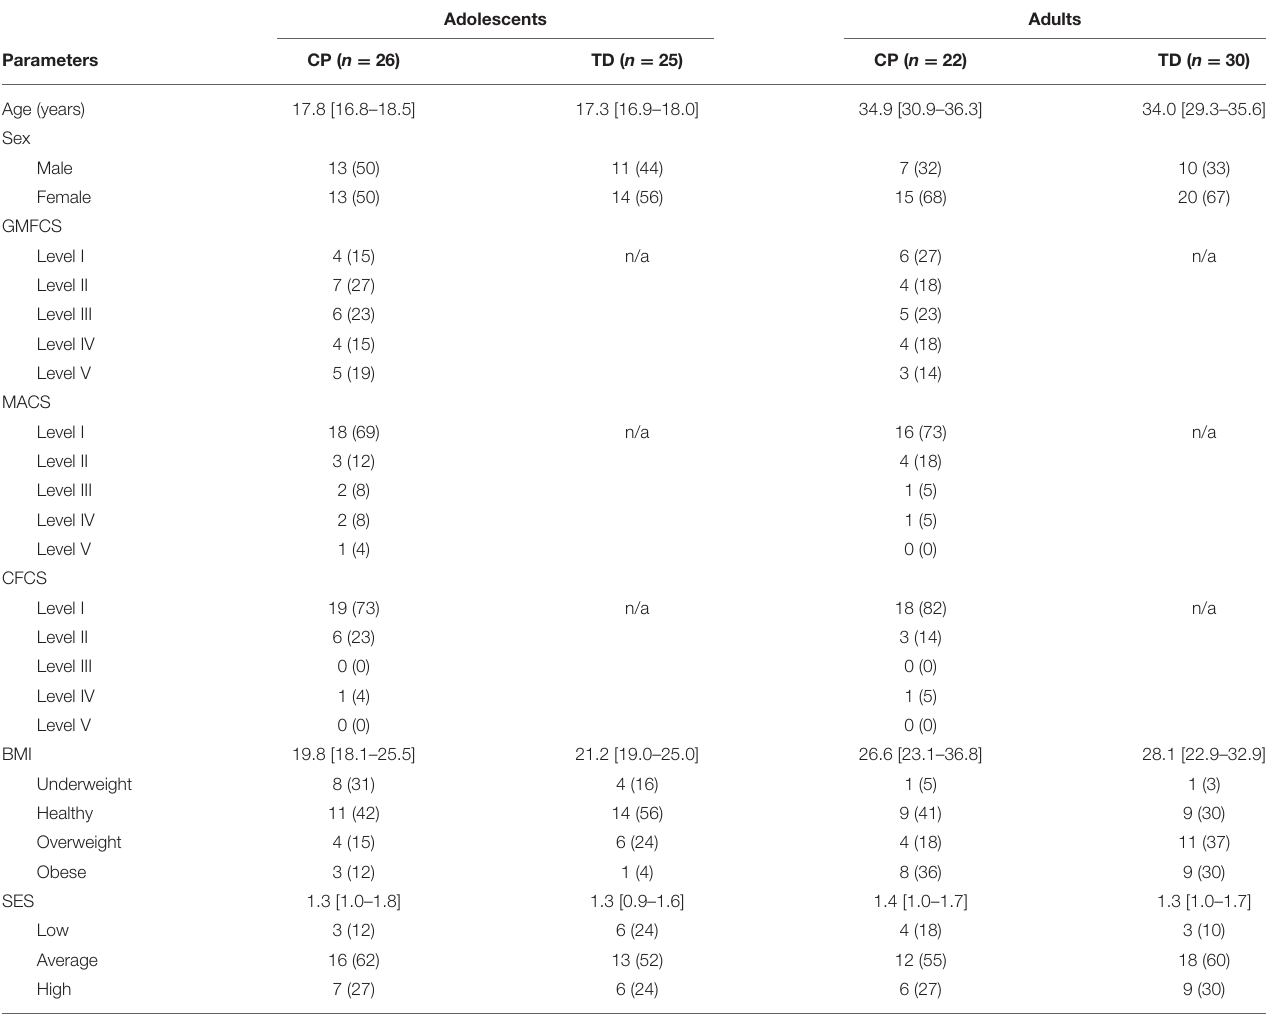
TABLE 1 | Overview of participant’s characteristics expressed in median [interquartile ranges] or n (%).